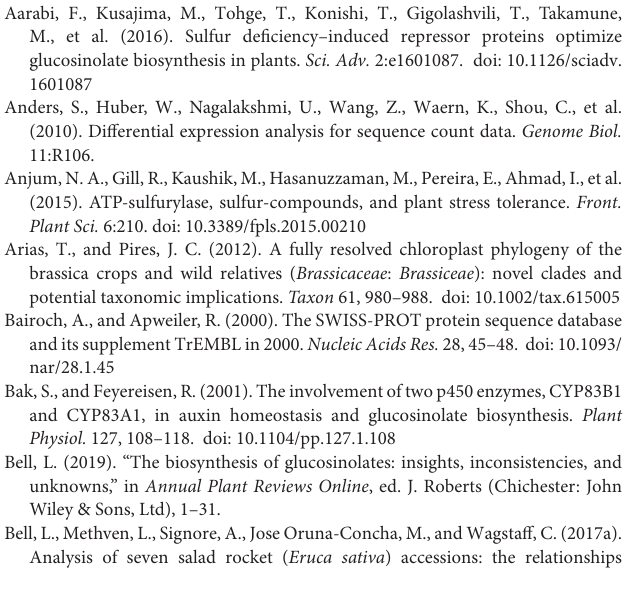
Supplementary Figure 2 | Pearson correlation matrix of RNAseq biological sample replicate gene expression values. Replicates of each sample showed a